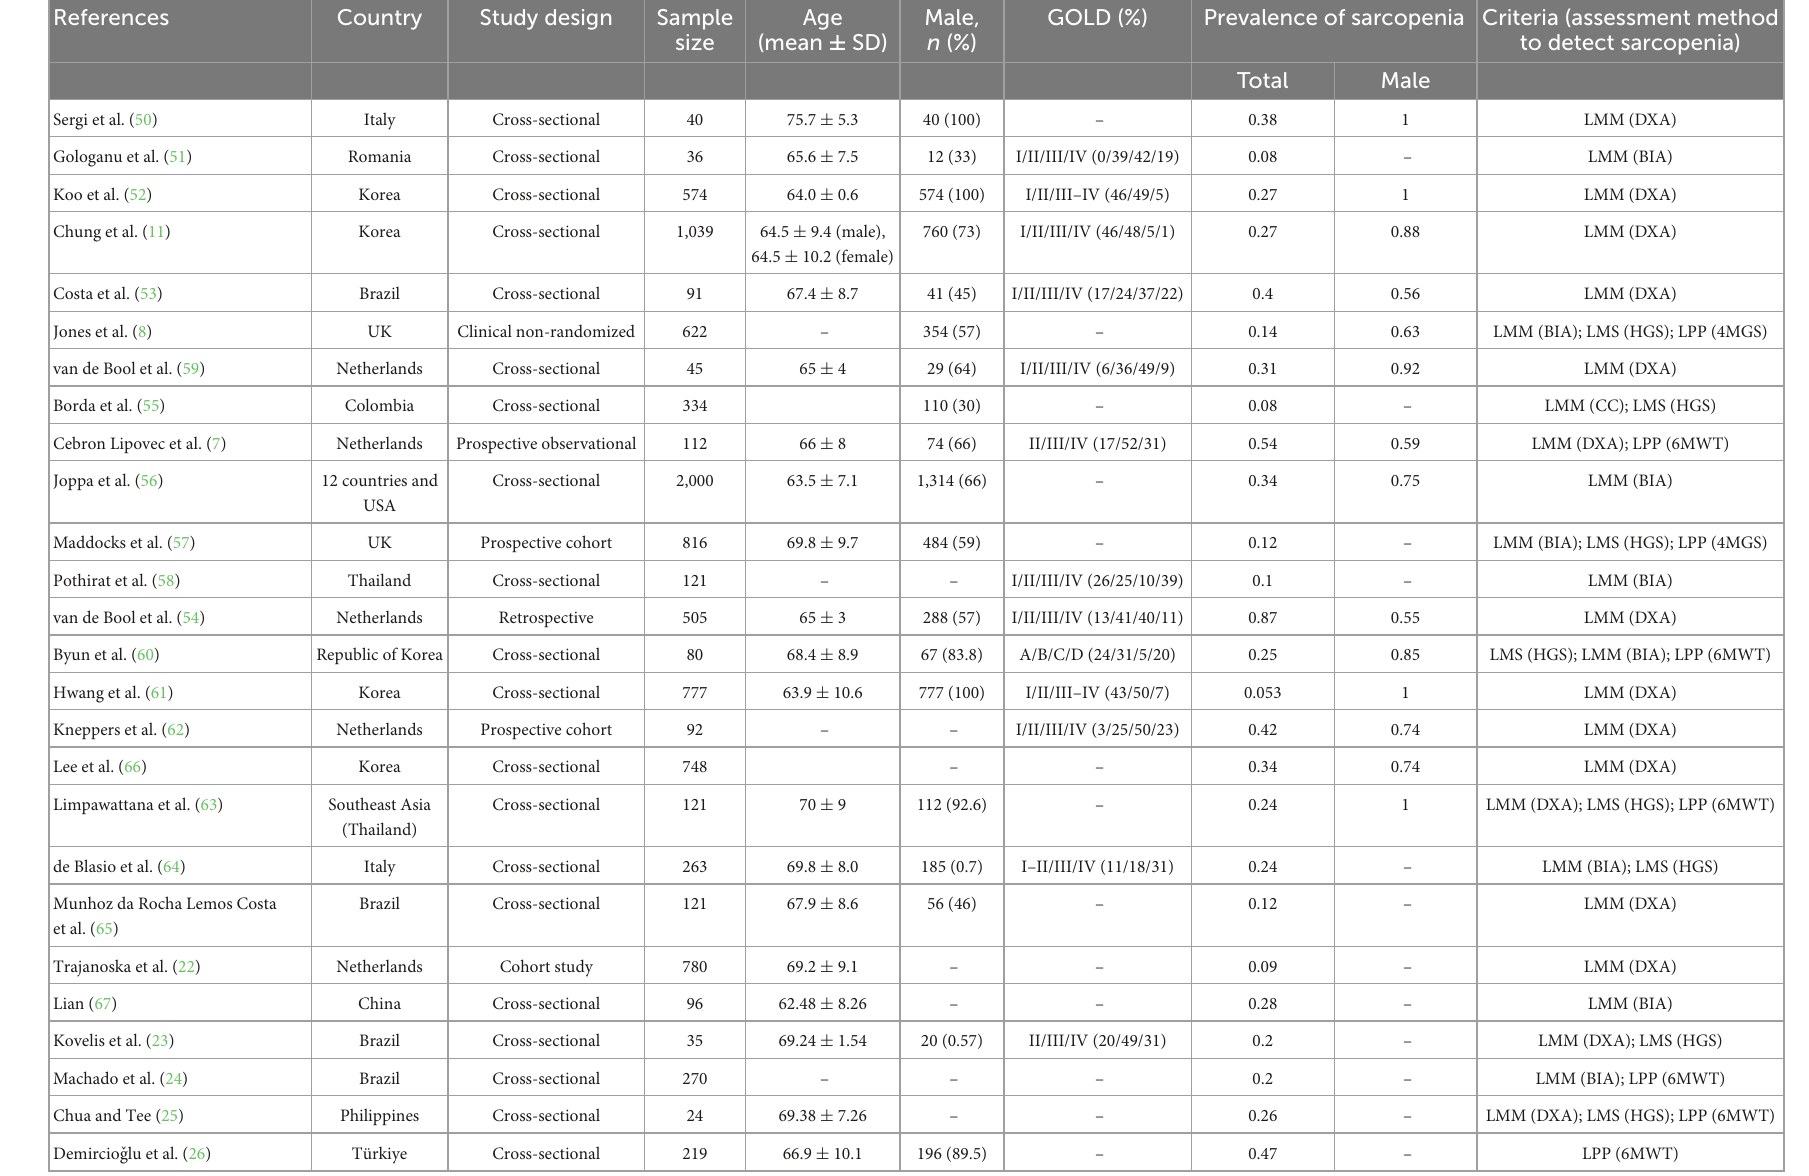
TABLE 1 Characteristics of the included studies regarding the prevalence of sarcopenia in subjects with